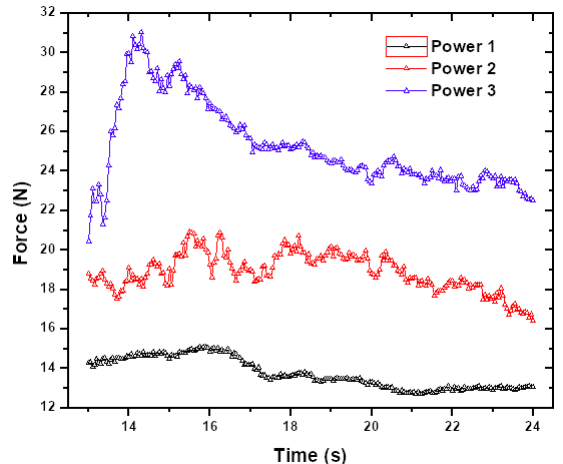
Figure 11. Lorentz adjustment for the experimental test for the average of all the forces.